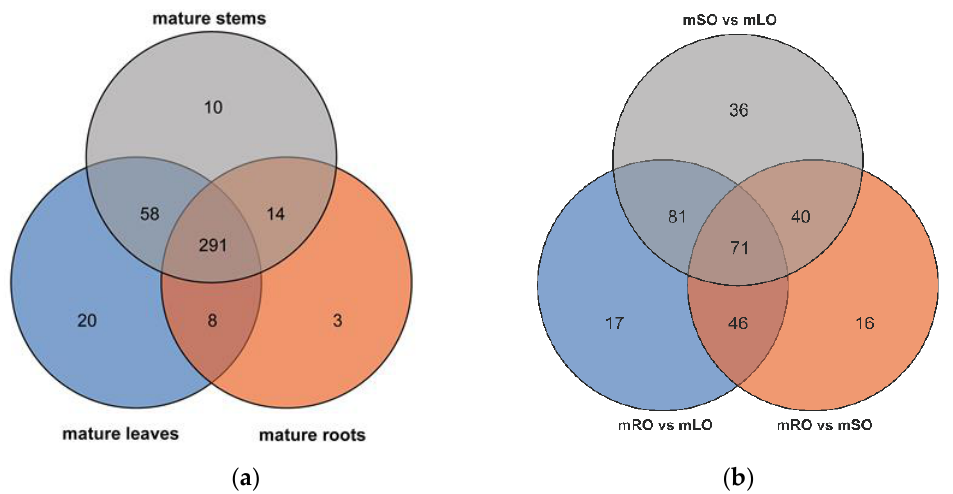
Figure 9. Venn diagram of the number of compounds. ( a ) Metabolites detected in the three mature parts. ( b ) Number of differential metabolites among the three mature parts. mOR, mOS, and mOL represent mature roots, mature stem, and mature leaves, respectively.